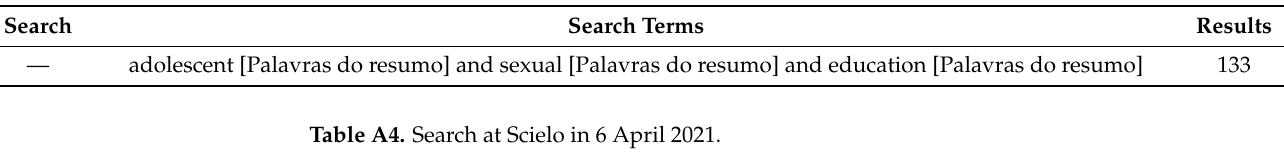
Table A3. Search at Lilacs in 6 April 2021.